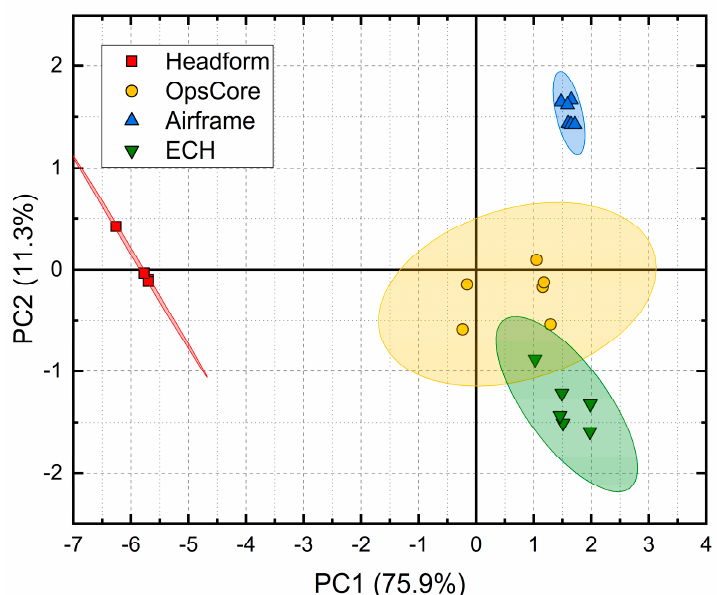
Figure 7. Principal Component Analysis of the surface pressures on the bare headform and equipped with Ops-Core, Airframe, and ECH helmets. The data were recorded at 70 kPa (~10 psi) nominal shock wave intensity, and the scores plot illustrates the clustering in the space of two principal components, PC1 and PC2. The shaded areas surrounding the data points are 95% confidence ellipses.